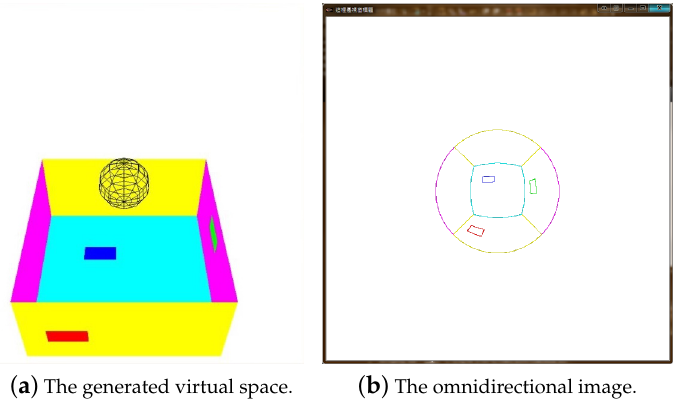
Figure 4. The simulated virtual environment and the image created by the omnidirectional camera model’s projection.